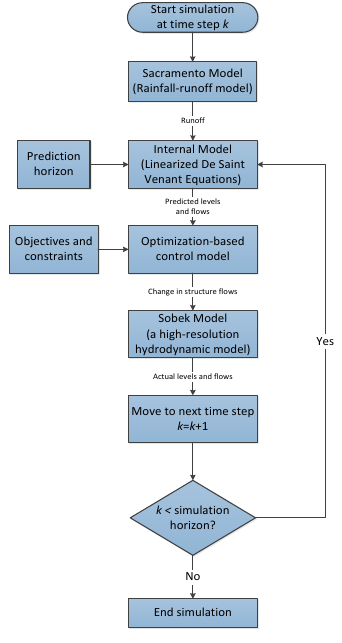
Figure 2. Simulation-optimization framework.